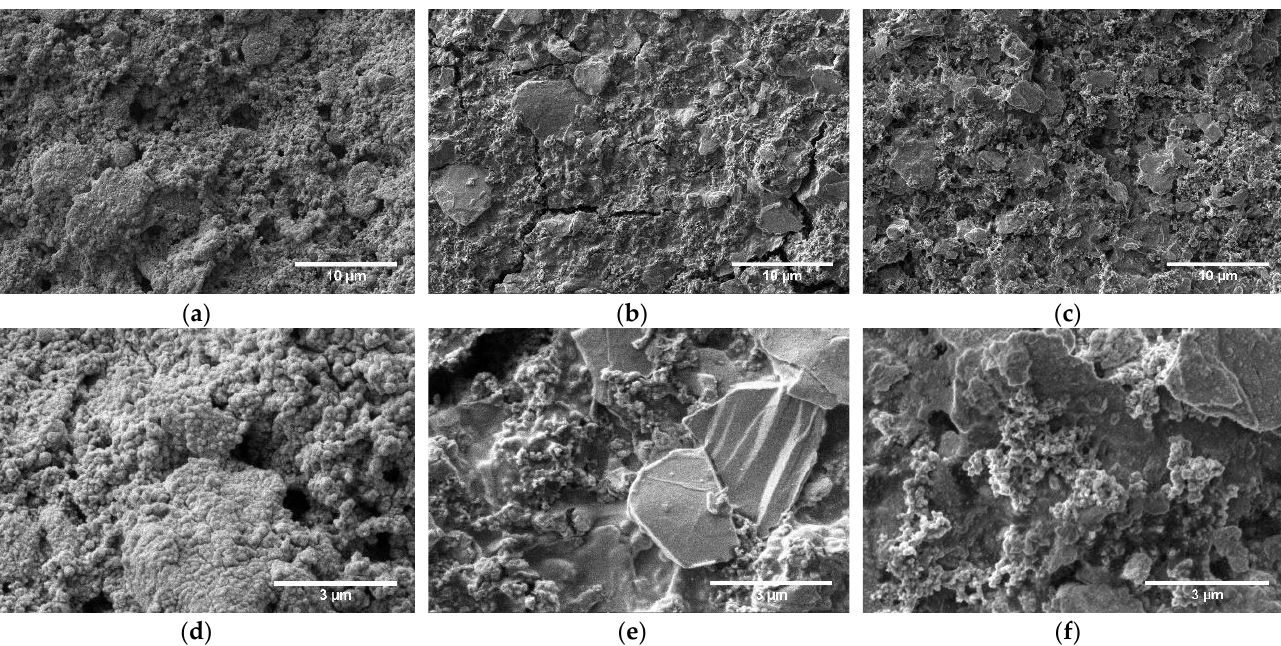
Figure 7. SEM of Na 0.67 MnO 2 electrodes cycled at 1 C for 500 cycles, prepared with ( a , d ) PVDF; ( b , e ) Na alginate and ( c , f ) TBA alginate binders. The length of the scale bar is 10 μ m for images in the top row and 3 μ m for images in the bottom row.